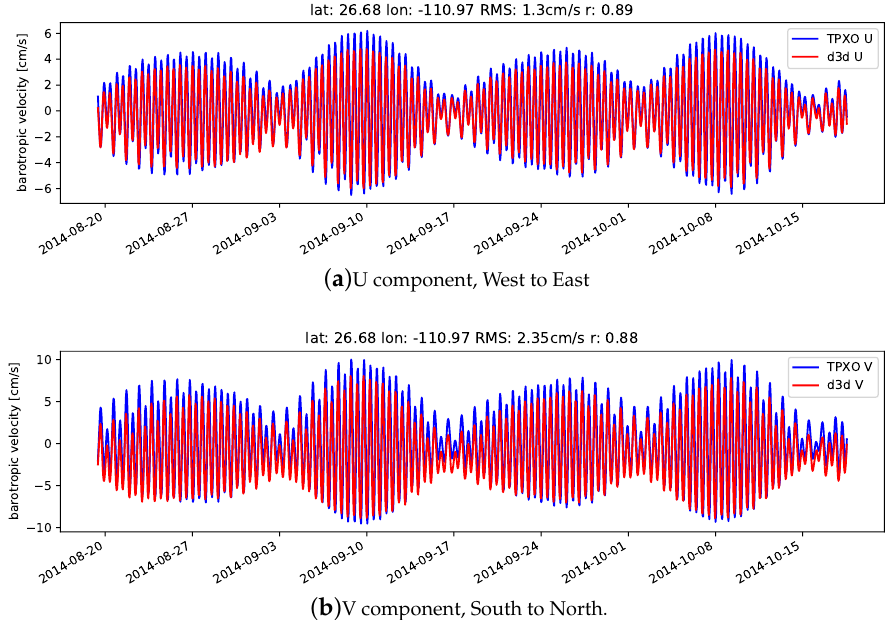
Figure 10. Time-series of components of the barotropic current at latitude 26.78 N, longitude—110.97 E. The delf3D (d3d) components have been depth-averaged for comparison. All dates in UTC. The solutions, TPXO versus Delft3d, are generally in good agreement. The Pearson correlation in the Upper Gulf exceeds 0.9 for both components and the root mean square (RMS) errors are acceptable. Not surprisingly, the correlation drops towards the south of the Gulf, to 0.88. Here the deep sections, around 2000 to 3000 m, pose a challenge to the barotropic formulation.